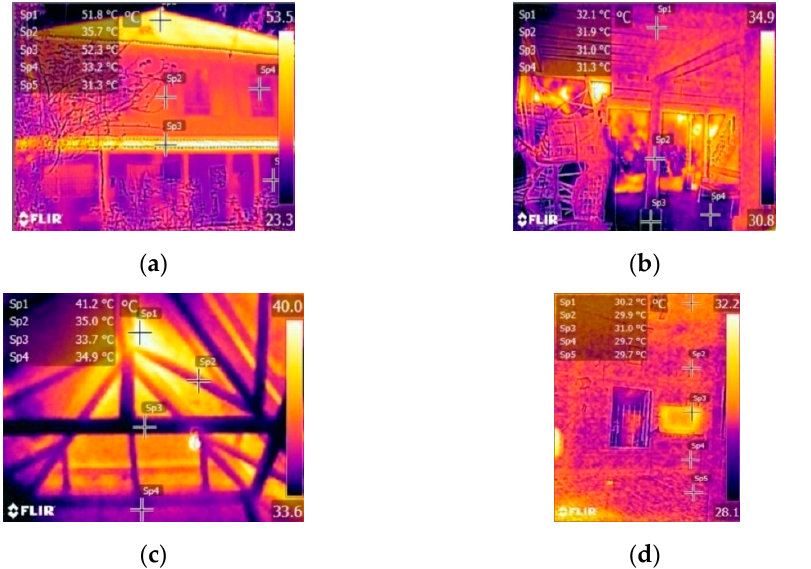
Figure 7. Surface temperature of H-3: ( a ) outdoor, ( b ) under elevated platform, ( c ) roof and ( d )